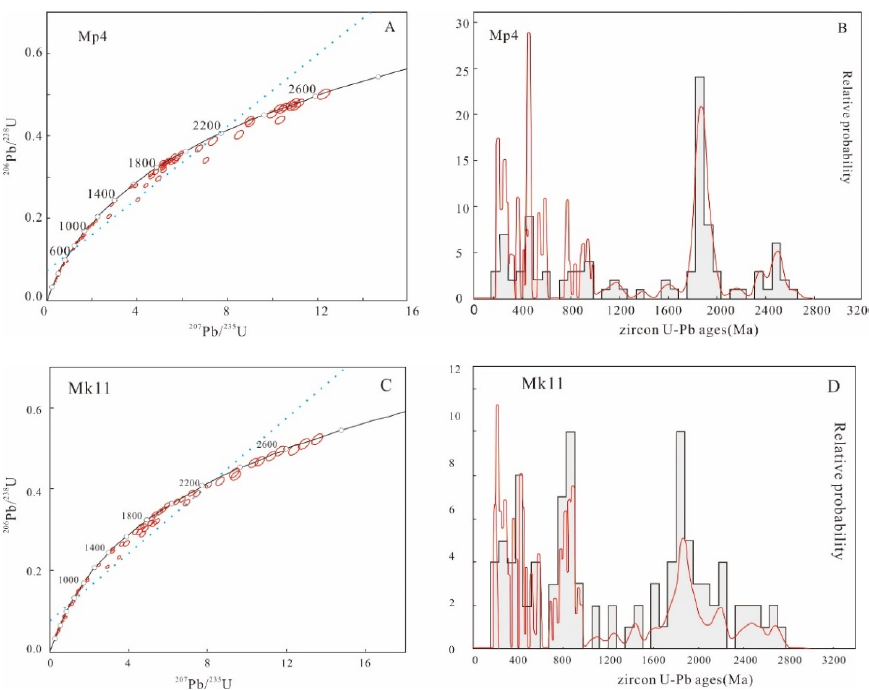
Figure 5 . U-Pb concordia diagrams and age probability plots for samples of Jingxing at Qamdo Ba- sin. ( A , B ) Sample MP4 of Mangda section. ( C , D ) Sample MK11 of Mangkang section. ( A , B ) Sample MP4 of Mangda section. ( C , D ) Sample MK11 of Mangkang